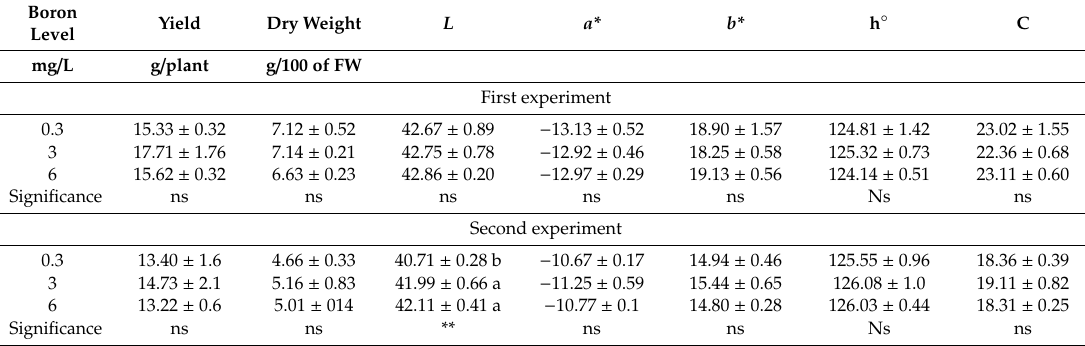
Di ff erent letters within each column and experiment indicate that mean values are significantly di ff erent, according to the Least Significant Di ff erence ( α = 0.05). Significance: ns = not significant; ** p ≤ 0.01 FW: fresh weight.